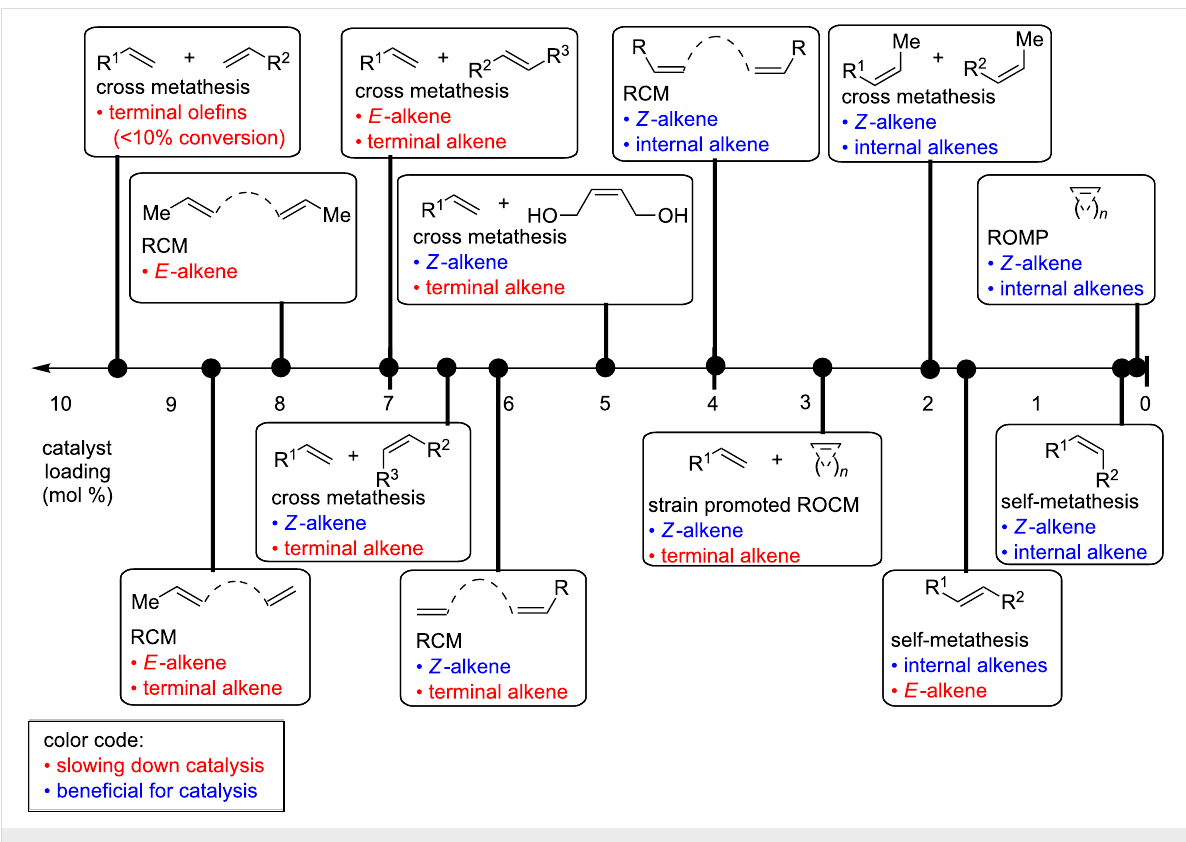
Figure 5: Catalyst loading required for different types of metathesis